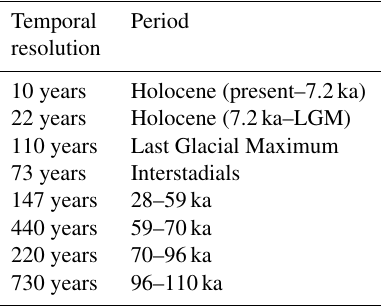
Table 1. Temporal resolution of the NEEM ice core in accordance with the GICC05modelext-NEEM-1 age scale (Rasmussen et al., 2013). Ice samples for ICP-MS analysis were collected with a res- olution of